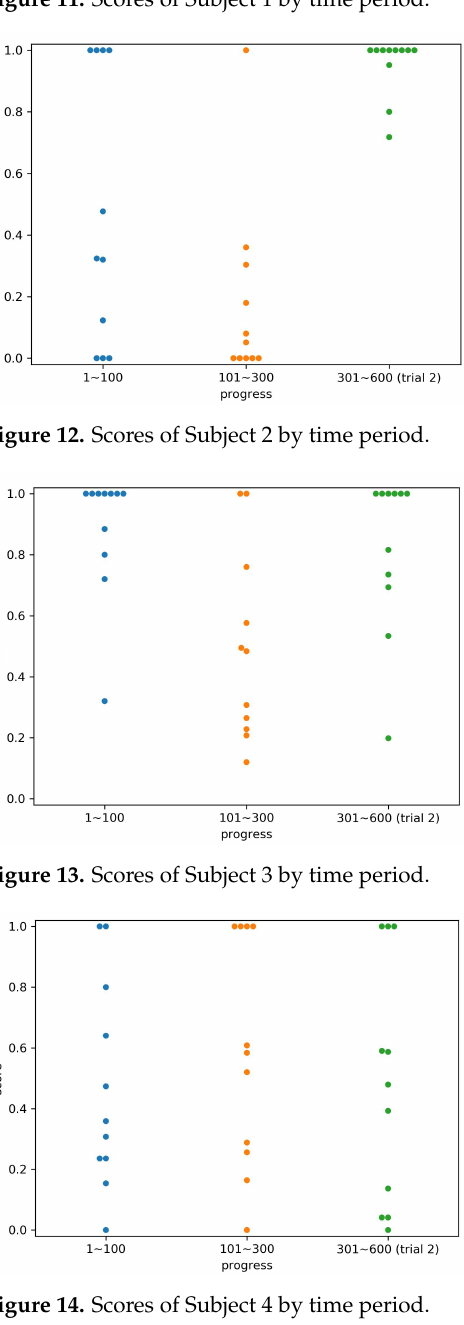
Figure 11. Scores of Subject 1 by time period.